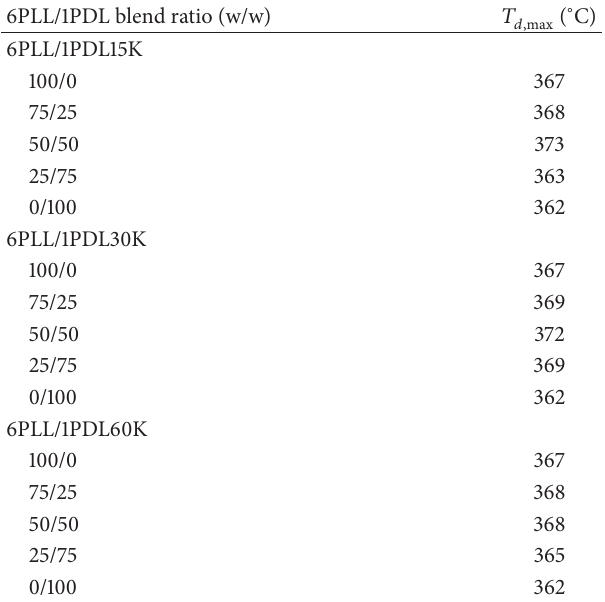
Table 2: 𝑇 𝑑, max of 6PLL, 1PDL, and 6PLL/1PDL